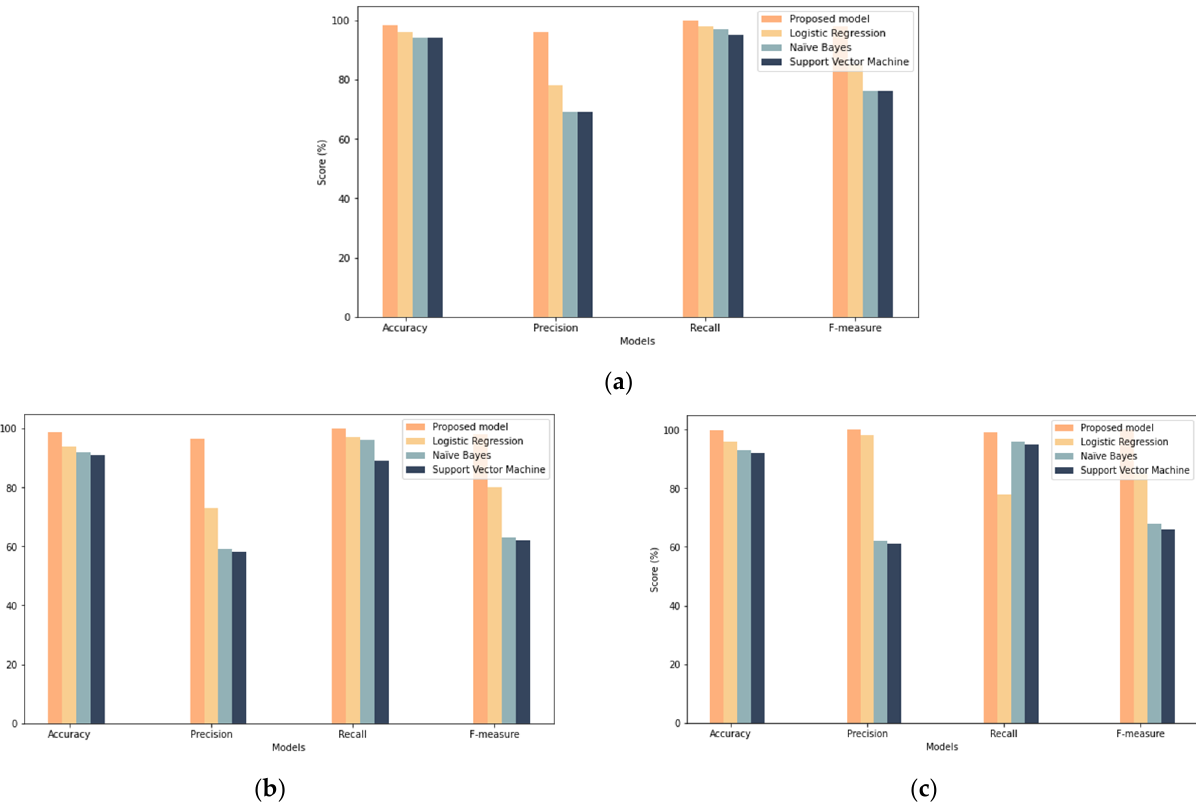
Figure 15. Comparison with machine learning results: ( a ) results for the 25% sample size, ( b ) results for the 50% sample size, ( c ) results for the 100% sample size.